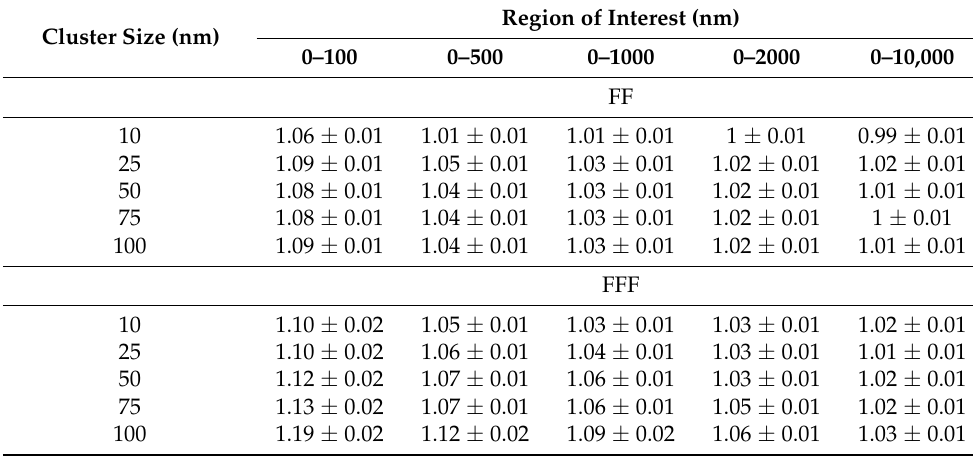
Table 4. Average values of DEF with the calculated errors in regions of